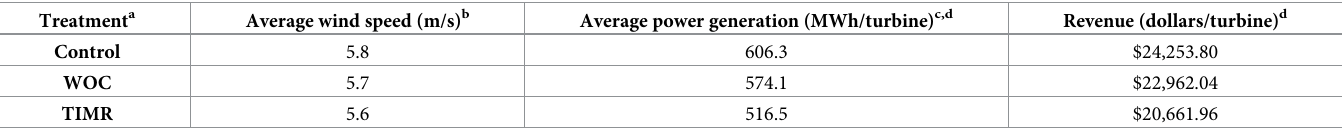
Table 4. Observed power production for 3 treatment groups at the Blue Sky Green Field Wind Energy Facility, Fond du Lac County, Wisconsin, July 15 − September 30, 2015. Treatment a